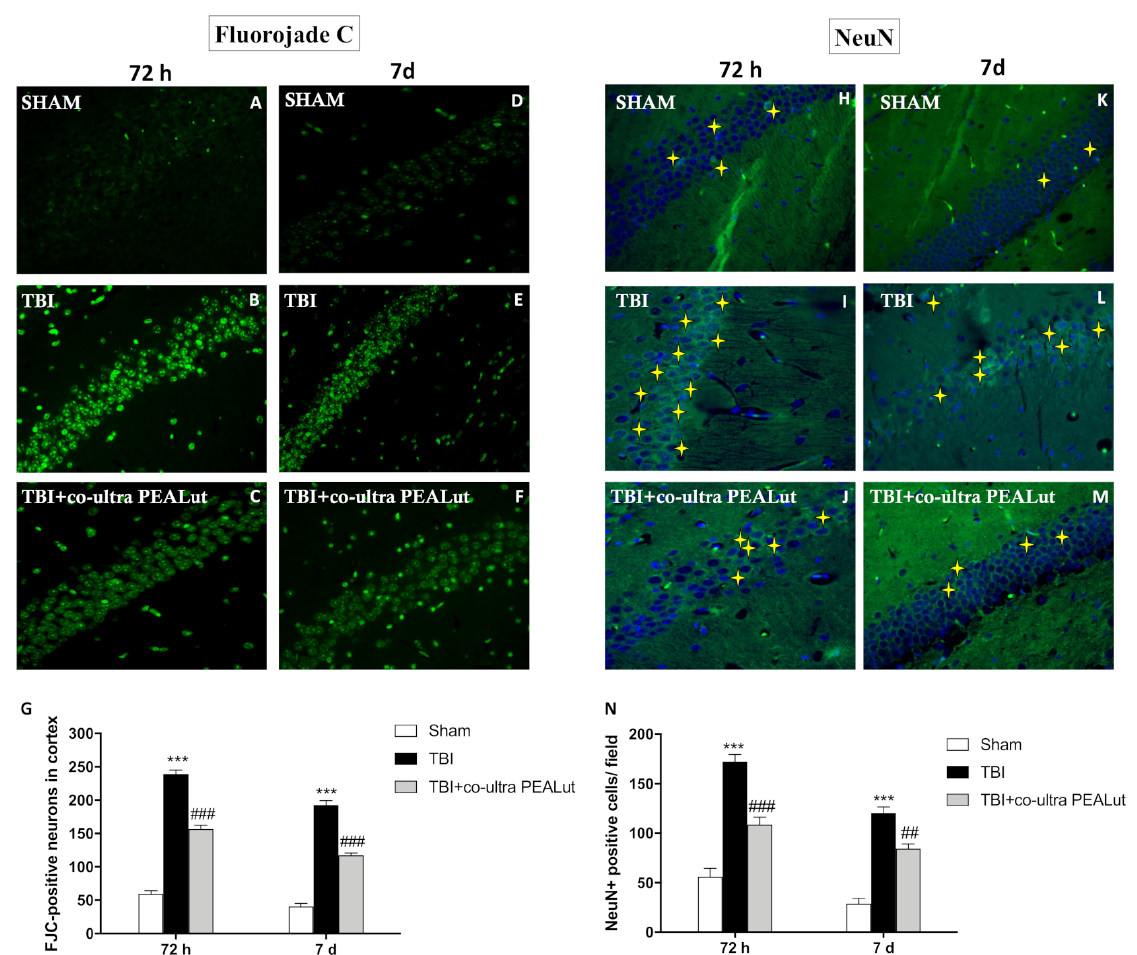
Figure 3. Effect of co-ultra PEALut on neuronal degeneration. Fluoro-Jade-positive neurons were significantly recognized in TBI-72 h ( B , G ) and TBI-7 d ( E , G ) groups, compared to respective control mice ( A , D , G ). Co-ultra PEALut reduced the neurodegeneration process at 72 h ( C , G ) and 7 d ( F , G ), following TBI. A considerable number of NeuN-positive cells were detected in TBI-72 h ( I , N ) and TBI-7 d ( L , N ) groups, compared to sham groups ( H , K , N ). Co-ultra PEALut administration considerably reduced NeuN-positive cells after 72 h ( J , N ) and 7 d post-TBI ( M , N ). Magnification 40 × . Yellow stars indicate the positive staining for NeuN. Data are expressed as Mean ± SEM from N = 10 mice for each group. One-way ANOVA test. *** p < 0.001 vs. corresponding Sham group; ## p < 0.01 vs. corresponding TBI. ### p < 0.001 vs. corresponding